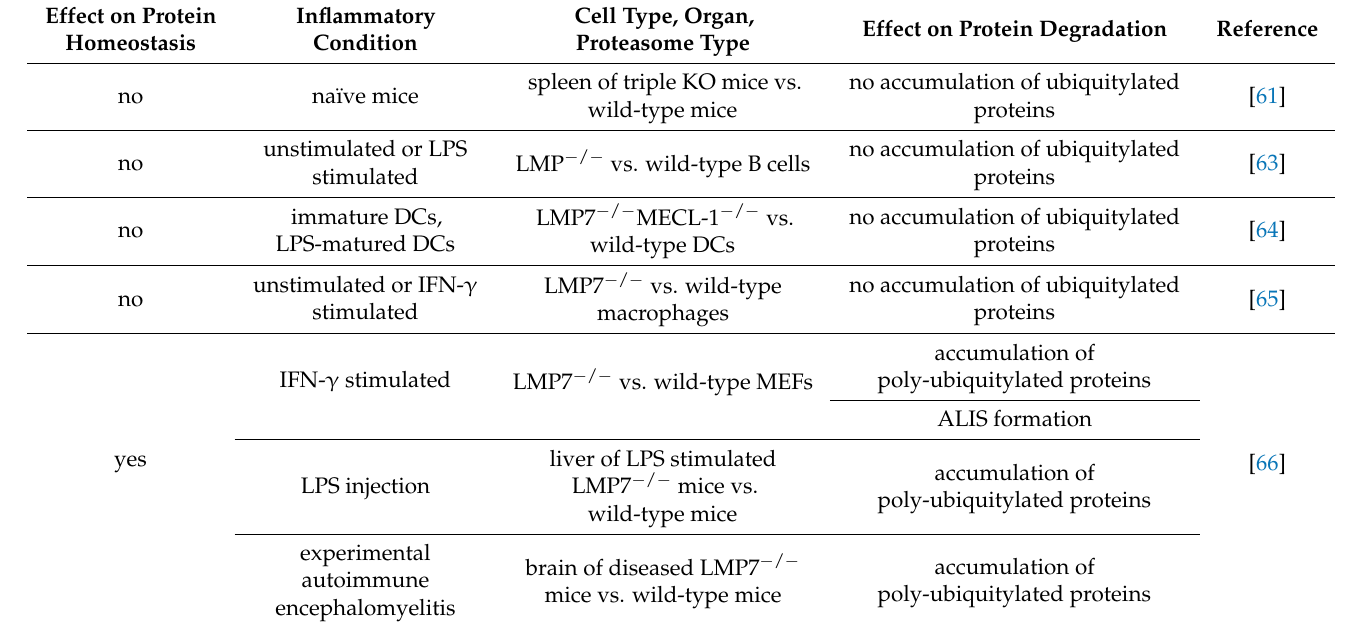
Table 1. Summary of studies investigating the effect of immunoproteasomes on protein homeostasis. Effect on